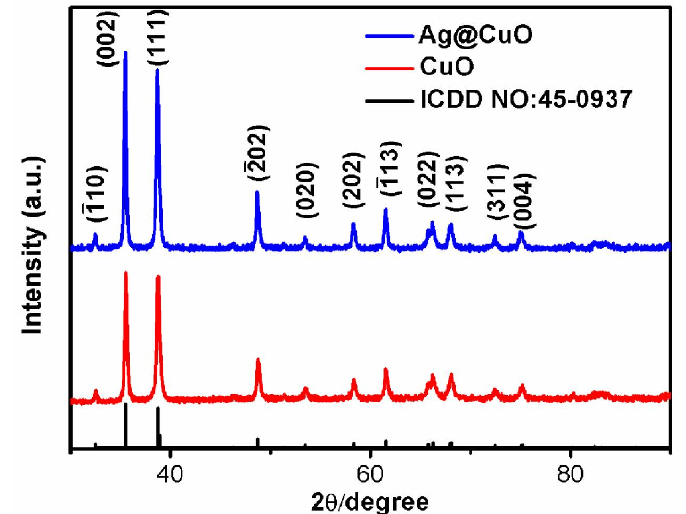
Figure 1. X-ray di ff raction (XRD) pattern of CuO and Ag@CuO flower-like material